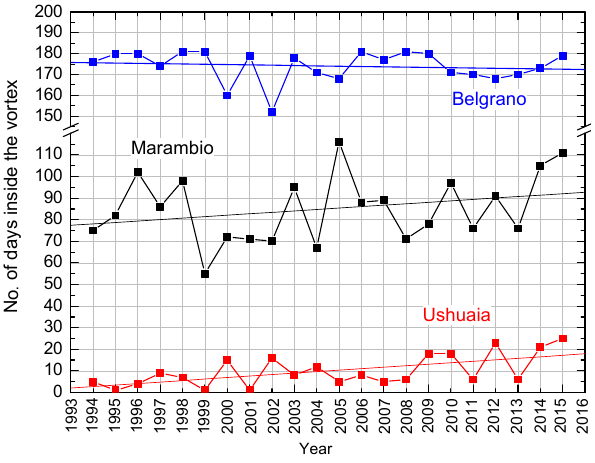
Figure 9. Annual evolution of the number of days that the sta- tions spent inside the polar vortex at 530K according to the Nash et al. (1996) criteria.